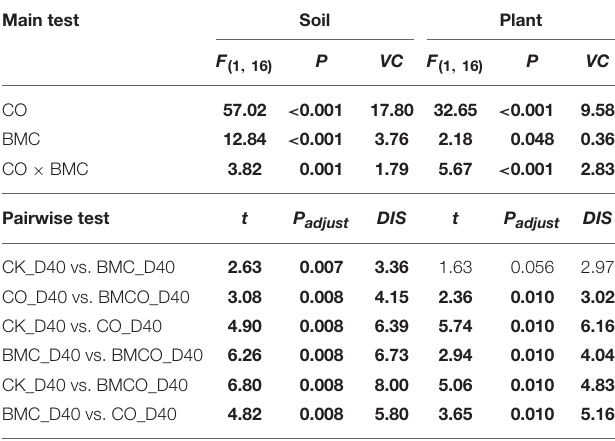
TABLE 2 | Effect of treatments (CK: control, BMC: biochar–mineral complex, CO: compost, BMCO: BMC + CO) on Euclidean distance of